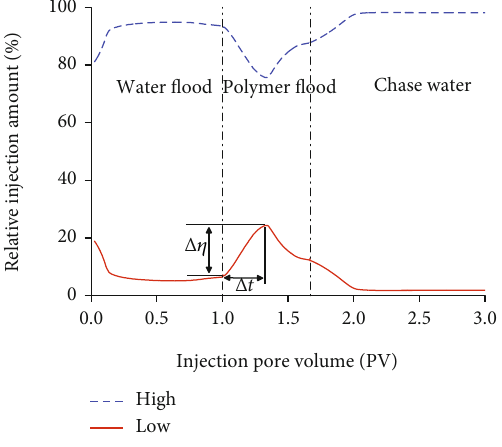
Figure 4: Injection conformance behavior as a function of the injection pore volume.